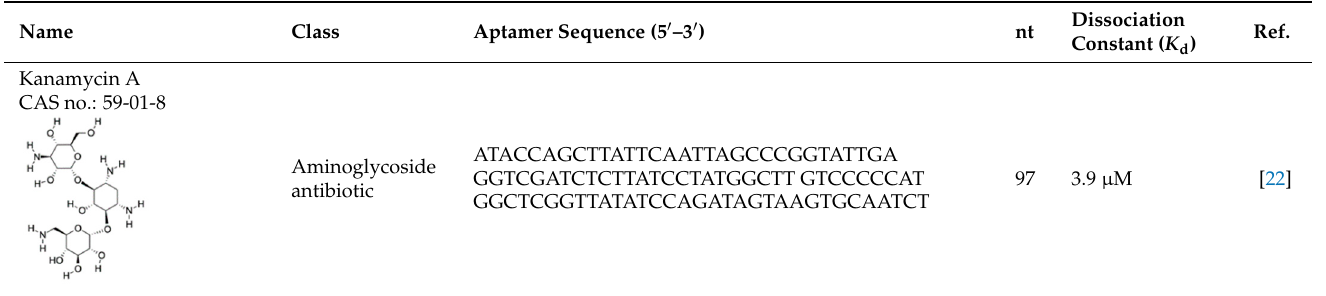
Table 1. A list of small molecule contaminant-specific aptamers developed by Capture-SELEX method as of to